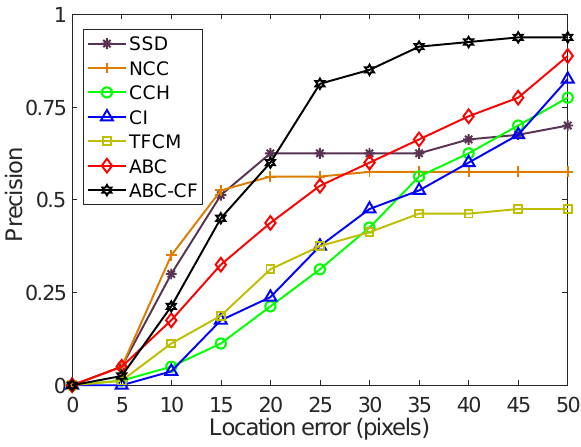
Figure 13. Precision plot in Tiger 1 data.